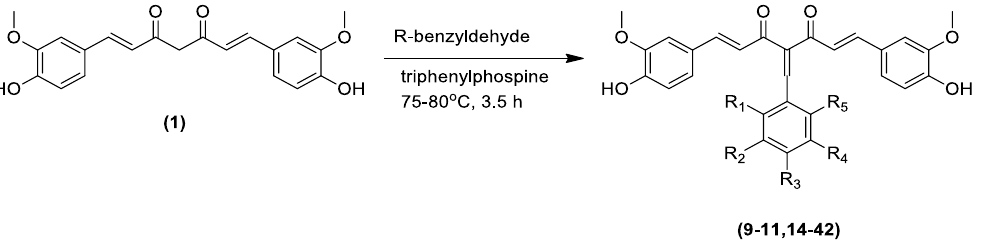
Figure 14. The reaction scheme and the chemical structures of derivatives ( 14 ) and ( 15 ), as synthesized by Knoevenagel condensation [37,38,70].